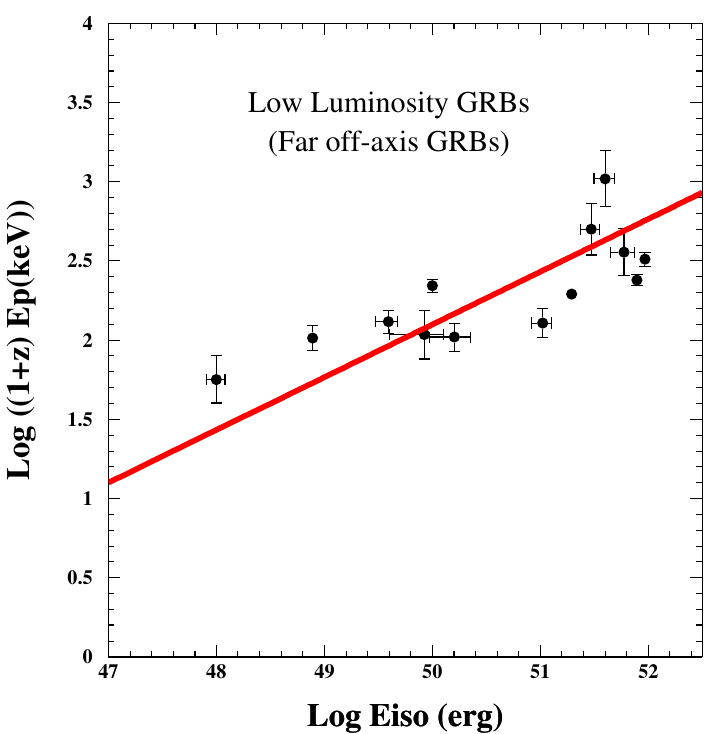
Figure 4. The [ E p , E iso ] correlation in LGRBs viewed far off axis (which include the so-called low- luminosity LGRBs, and XRFs) [77]. The line is the CB model prediction [53,73,74] of Equation (5).